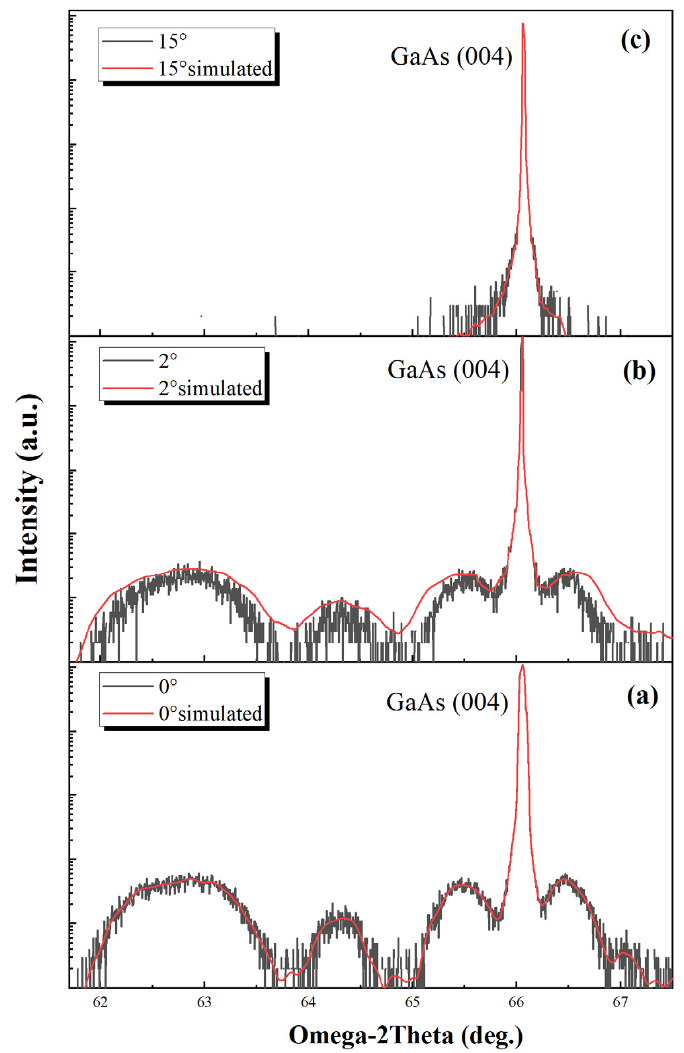
Figure 2. Omega-2 θ scans around the (004) symmetric XRD patterns of InGaAs/GaAsP QWs grown on substrates with misorientations of ( a ) 0°, ( b ) 2°, and ( c ) 15°.